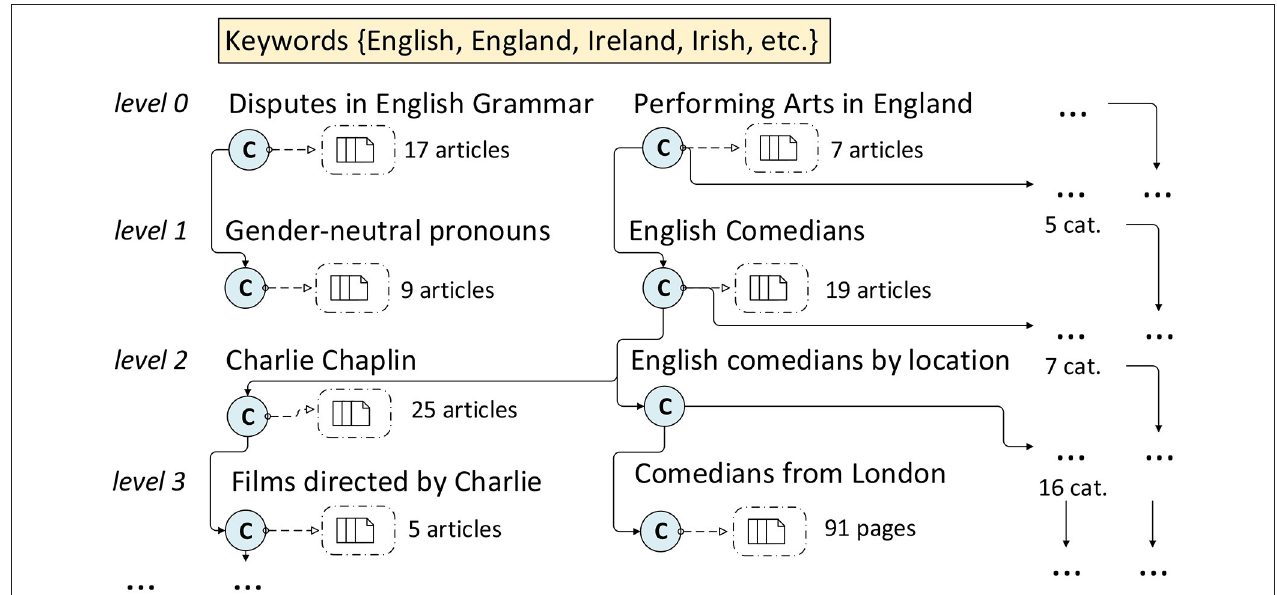
FIGURE 1 | Crawling down the category graph with keywords (strategy